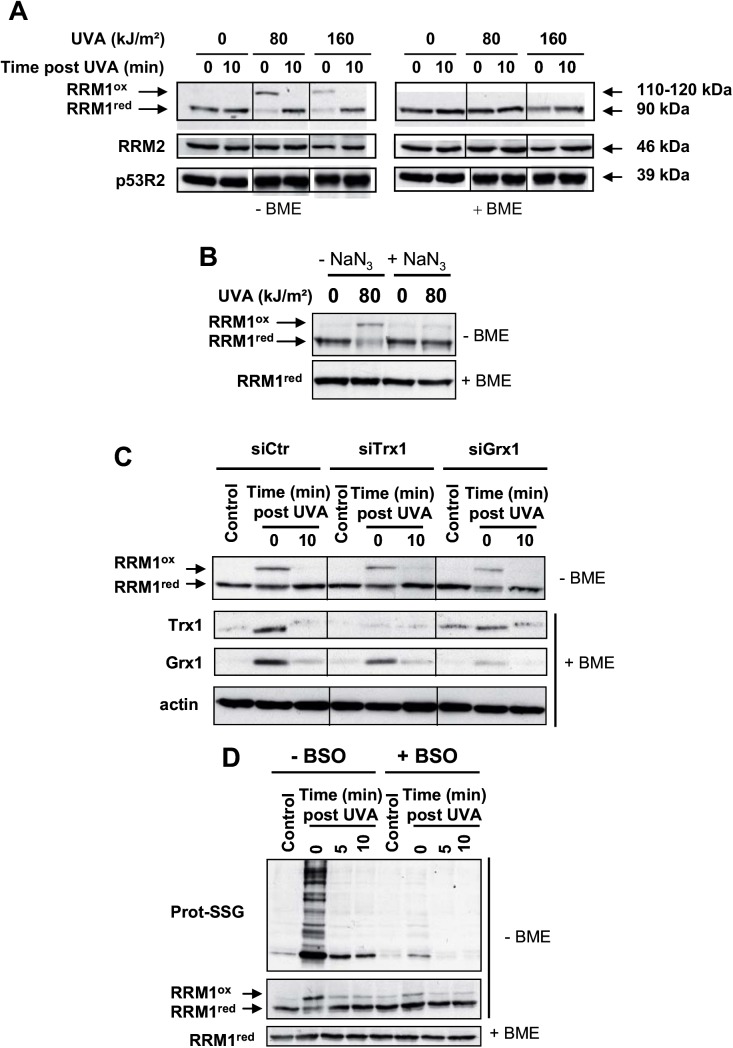
Reversible oxidation of the RRM1 subunit of RNR in response to UVA-induced ROS.MRC5Vi cells were untreated or exposed to UVA radiation in the absence (A) or presence (B) of 10 mM NaN3. (C) MRC5Vi cells were transiently transfected with siCtr, siTrx1, or siGrx1 and 48 h post transfection exposed or not to 80 kJ/m2 of UVA. (D) Cells depleted (+ BSO) or not (- BSO) in intracellular GSH were exposed to 80 kJ/m2 of UVA and lysed either immediately or 5 and 10 min post UVA radiation. The expressions of RRM1, RRM2, p53R2, Trx1, Grx1, and proteins S-glutathionylated (prot-SSG) were detected by Western blotting in non reducing (- ß-mercaptoethanol, - BME) or reducing (+ ß-mercaptoethanol, +BME) conditions. Actin was used as a loading control. RRM1ox and RRM1red stand for the oxidized and reduced form of the RRM1 subunit of the RNR, respectively. Each blot is representative of 2 independent experiments. The vertical lines in panels A and C denote non-adjacent bands from the same blot. Numbers in brackets (panel A) indicate the apparent molecular weight of each subunit.